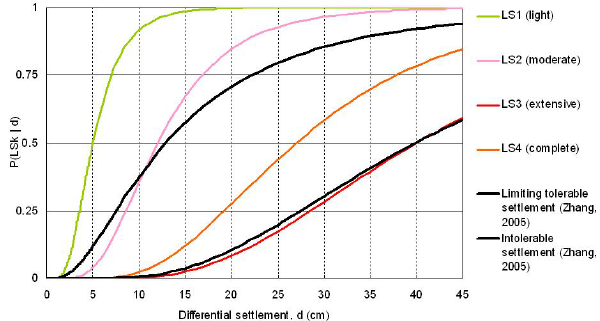
Fig. 10. Comparison between the proposed analytical fragility curves and the empirical ones provided by Zhang and Ng, corre- sponding to the settlements observed on 95buildings (see Zhang and Ng, 2005).